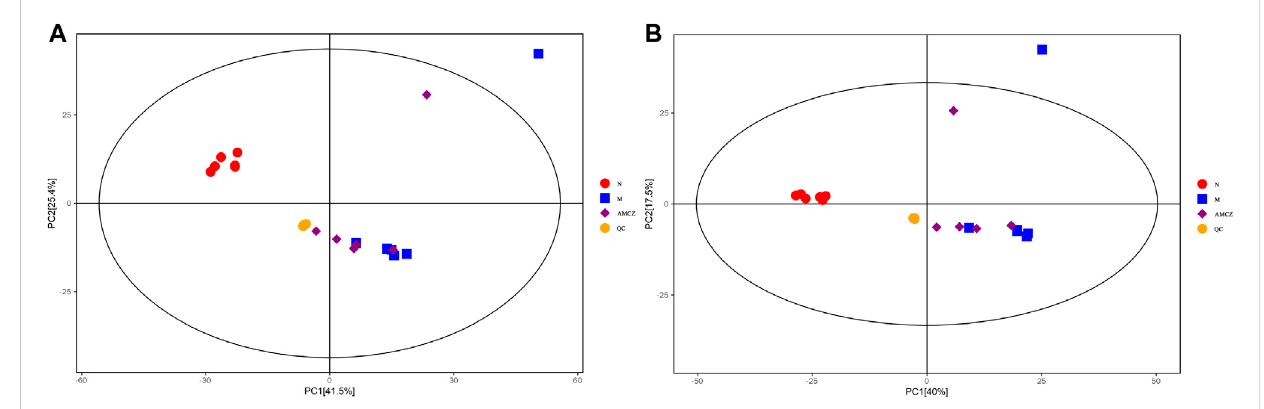
FIGURE 2 PCA score plots of three groups and QC samples. (A) positive ion mode; (B) negative ion